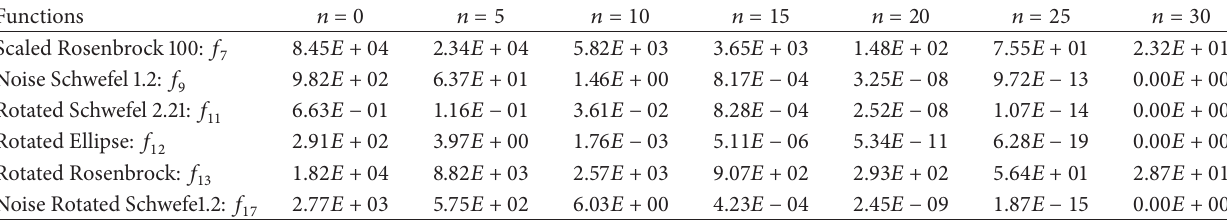
Table 3: Results of different numbers of variables being executed with the IVL